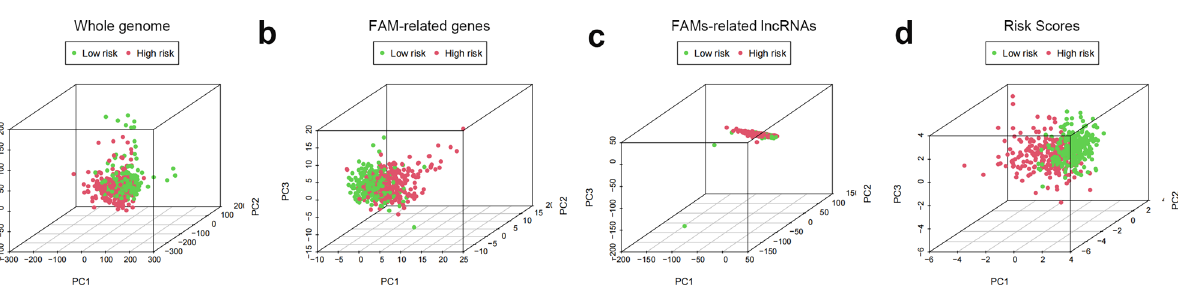
Figure 10. PCA profiles showing patient distribution based on ( a ) genome-wide; ( b ) zinc finger-associated genes; ( c ) zinc finger-associated lncRNAs; and ( d ) risk scores. The separation between red and green dots is stronger in the high- than in the low-risk